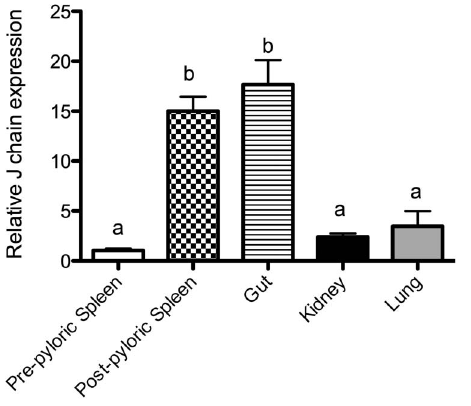
Figure 3. Tissue distribution of J chain expression in control Nigerian spotted lungfish ( P.dolloi ) (n=6). The relative expression of each gene was normalized first with the house keeping genes, and then divided by the average expression level in the pre-pyloric spleen, which had the lowest value. Bars represent means 6 standard error of four fish. Different letters represent statistically significant groups after Tukey’s test (p , 0.05).